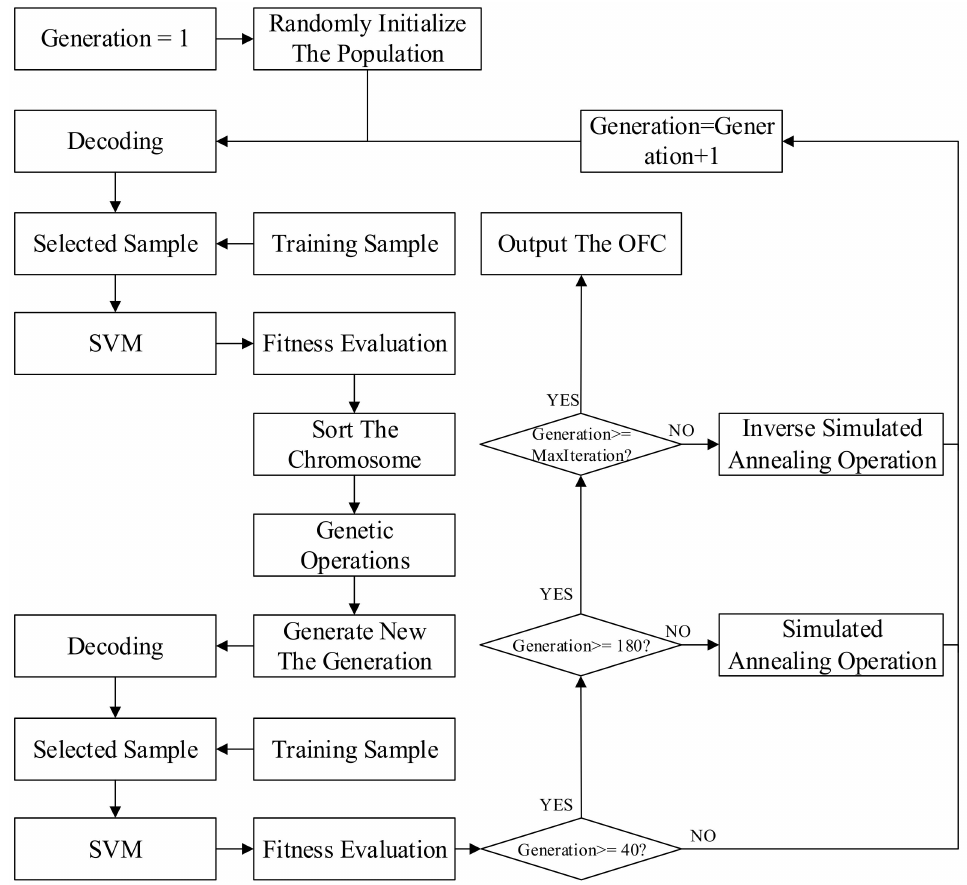
Figure 2. Flowchart of optimization selection based on 3-stage